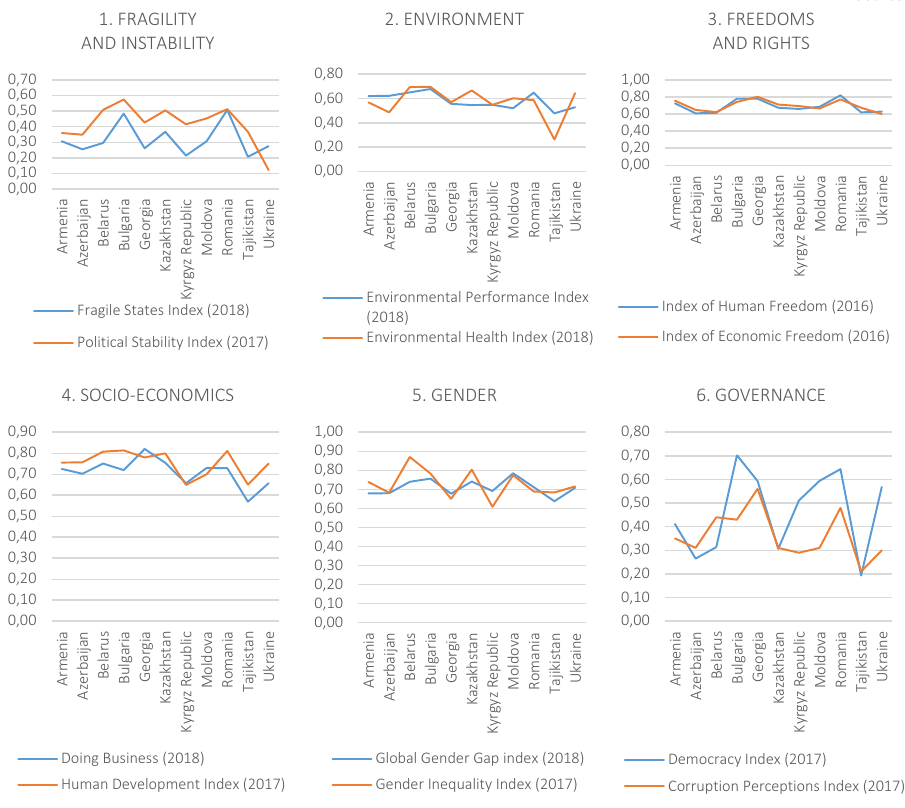
Figure 3. Institutional development